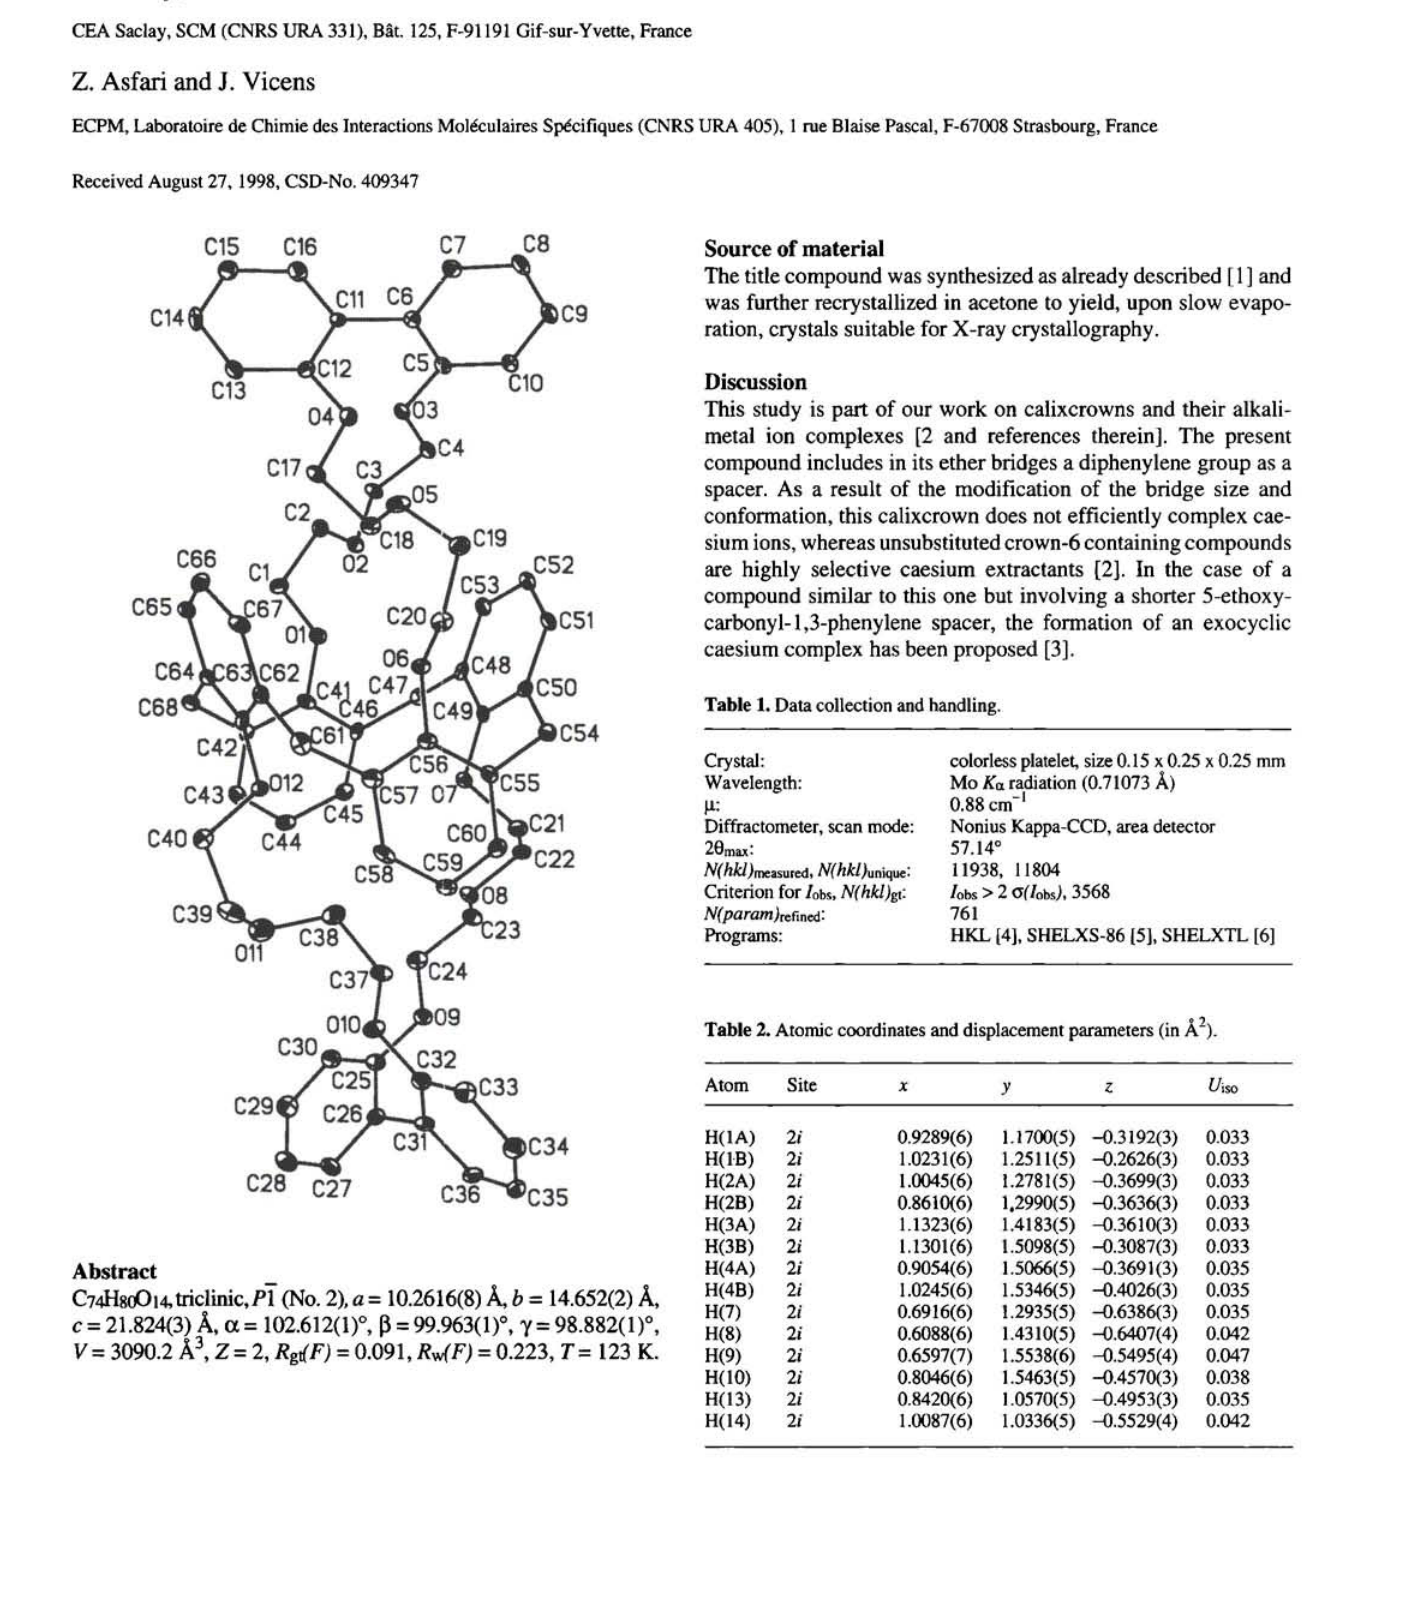
Table 2. Atomic coordinates and displacement parameters (in Â 2